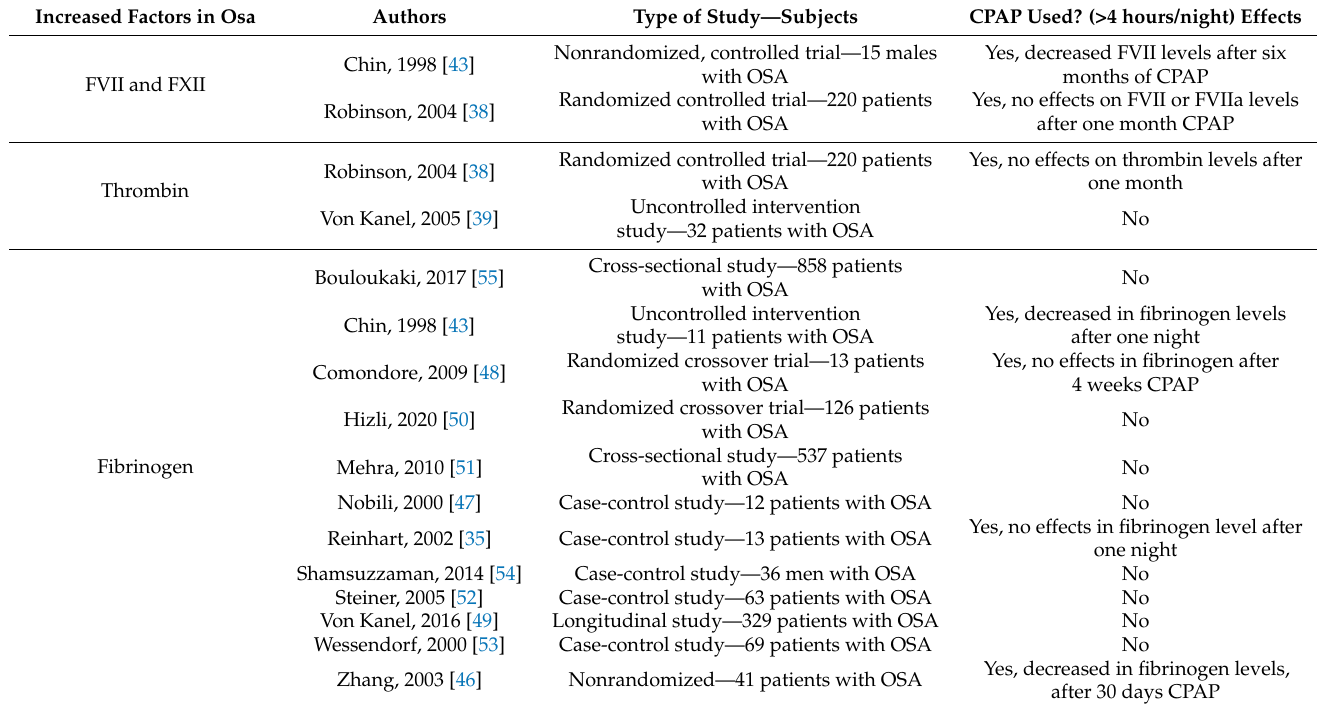
Table 1. Hemorheological and coagulation findings in obstructive sleep apnea (OSA) and the effect of continuous positive airway pressure